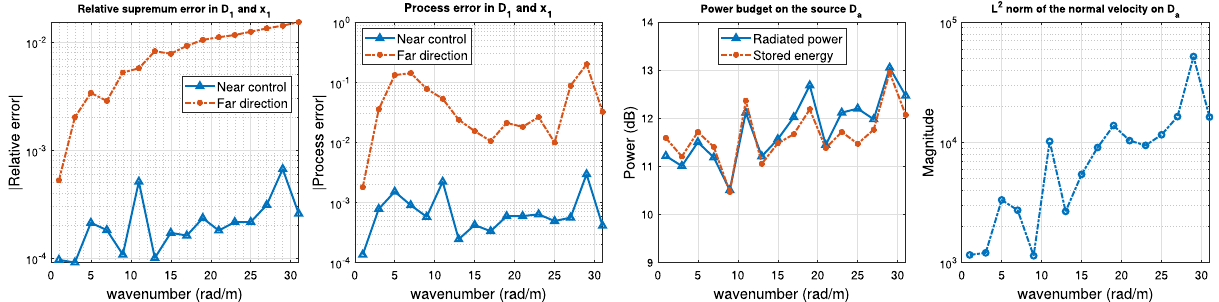
Figure 15. Results showing the control accuracy and the power budget varying with wavenumber k . From left to right, (1) Supremum error. (2) Process error. (3) Power budget on D a . (4) L 2 norm of normal velocity v n on D a .